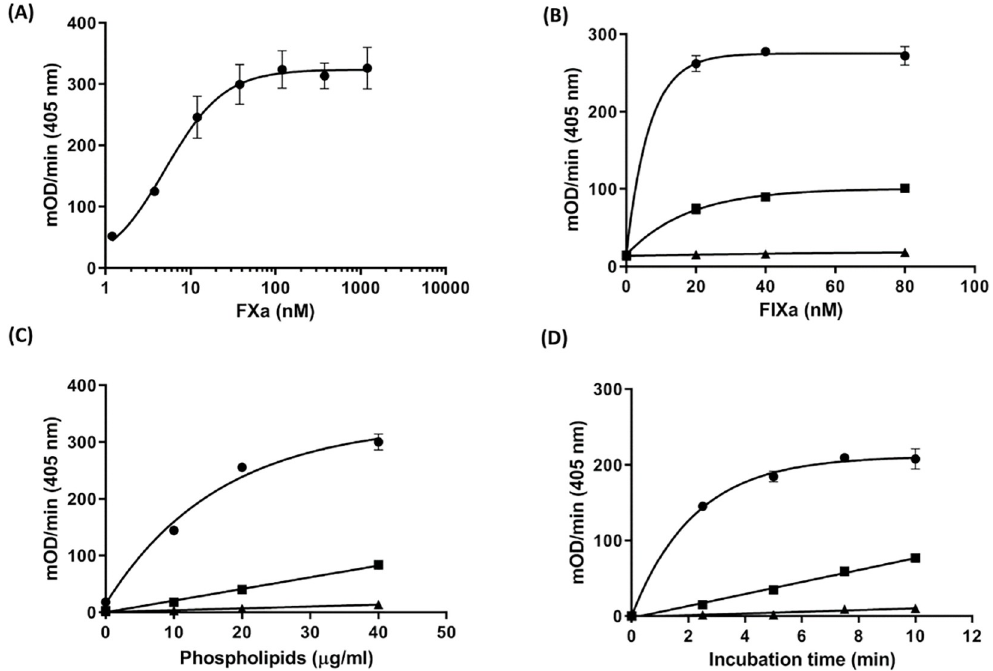
Fig 2. Assay optimization. (A) FXa-catalyzed substrate hydrolysis. To evaluate the maximal acceptable FXa concentration, 75 μ l of FXa diluted in a Tris-based buffer containing 20 μ g/ml phospholipids and 5 mM CaCl 2 were mixed with 25 μ l of 2 μ M FXa-specific chromogenic substrate S-2765 and substrate conversion was measured. (B) Optimization of the FIXa concentration. Different concentrations of FIXa (25 μ l) were mixed with 25 μ l of different concentrations of emicizumab and 25 μ l FX (final concentration of 150 nM) in the presence of phospholipids and calcium. After 5 min incubation at RT, 25 μ l of S-2765 (2 mM) were added and the substrate hydrolysis was measured. (C) Evaluation of the phospholipid concentration. The influence of increasing concentrations of phospholipids on emicizumab dependent FXa formation was measured at FIXa (40 nM) and FX (150 nM) in a Tris-based buffer containing different levels of phospholipids. (D) Influence of the incubation time on FXa formation. A reaction mixture prepared by mixing of FIXa (40 nM), FX (150 nM) and different concentrations of emicizumab was incubated for various incubation time followed by addition of S-2765 substrate and FXa-formation measurement. All samples were measured at 405 nm using the Synergy2 microplate reader. All data were collected in triplicate and expressed as the means ± s.d. In figures B to D, ● indicates 100 μ g/ml emicizumab; ■ , 10 μ g/ml emicizumab and ▲ indicated without